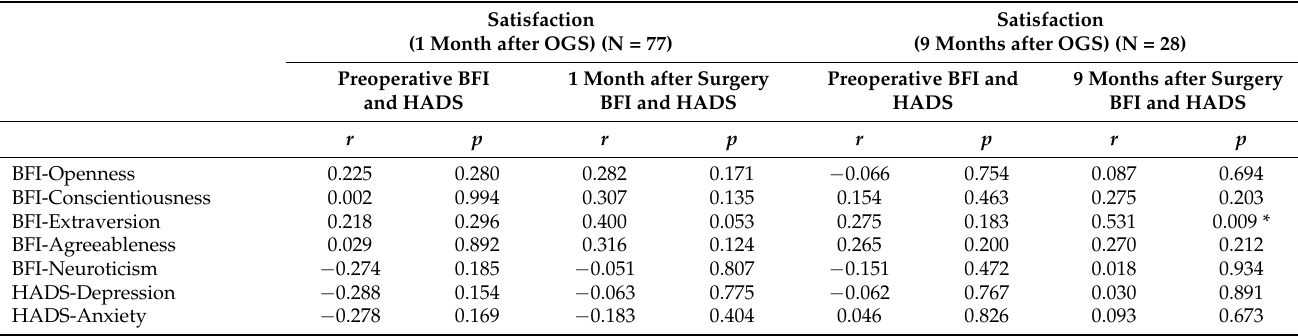
Table 2. Correlation between BFI and HADS (preoperative, 1 month and 9 months after OGS) and surgical